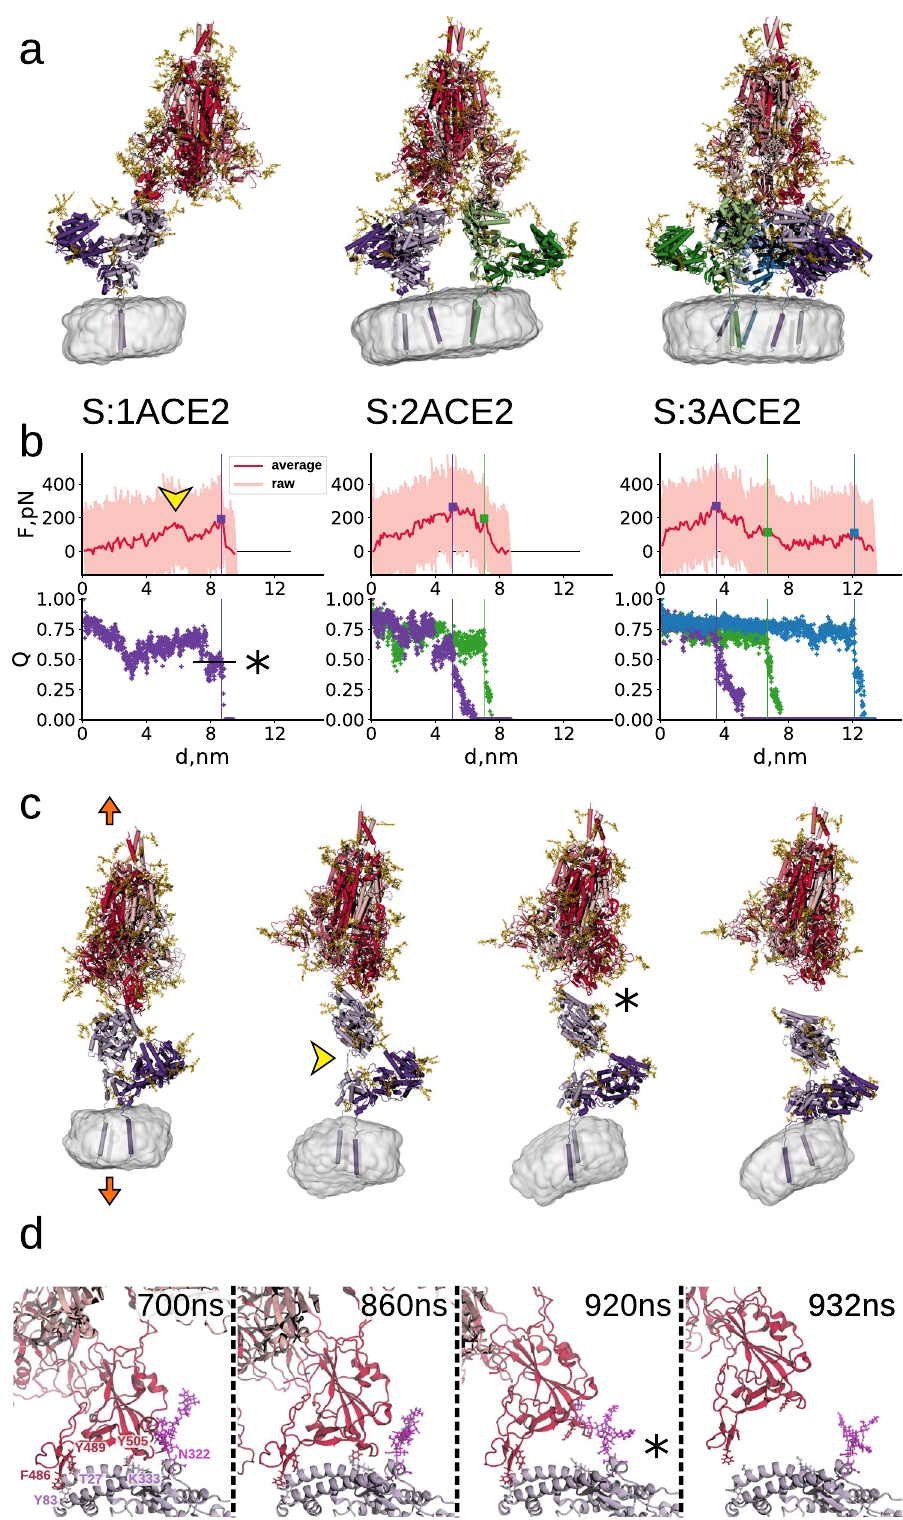
Fig. 3 | Constant velocity pulling simulations of Spike:ACE2 complexes. a Simulationsofone,two,andthreedimericACE2receptors(lefttoright;shadesof violet, green, blue; intracellular domain not shown) bound to a single Spike trimer (shades of red). The nanodisc membrane is shown in gray. Glycans on Spike and ACE2 are shown as gold sticks. b Force-extension ( d ) curves (top; 10-ns window average in solid red, raw data in pink) and fraction Q of Spike:ACE2 contacts (bottom). Vertical lines, yellow arrow, and star indicate dissociation events, the